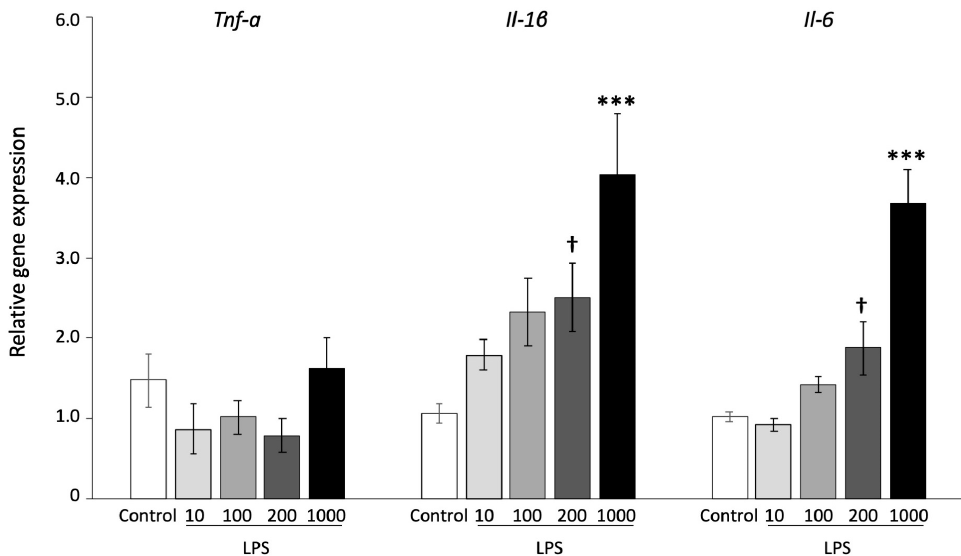
Figure 2. Gene expression of inflammatory cytokines in the uterus after administration of LPS. Mice were administered 0, 10, 100, 200, and 1000 µg/kg LPS and uteruses were collected after 6 h. The values are shown as mean ± SEM (n = 3). † p < 0.1, *** p < 0.001.